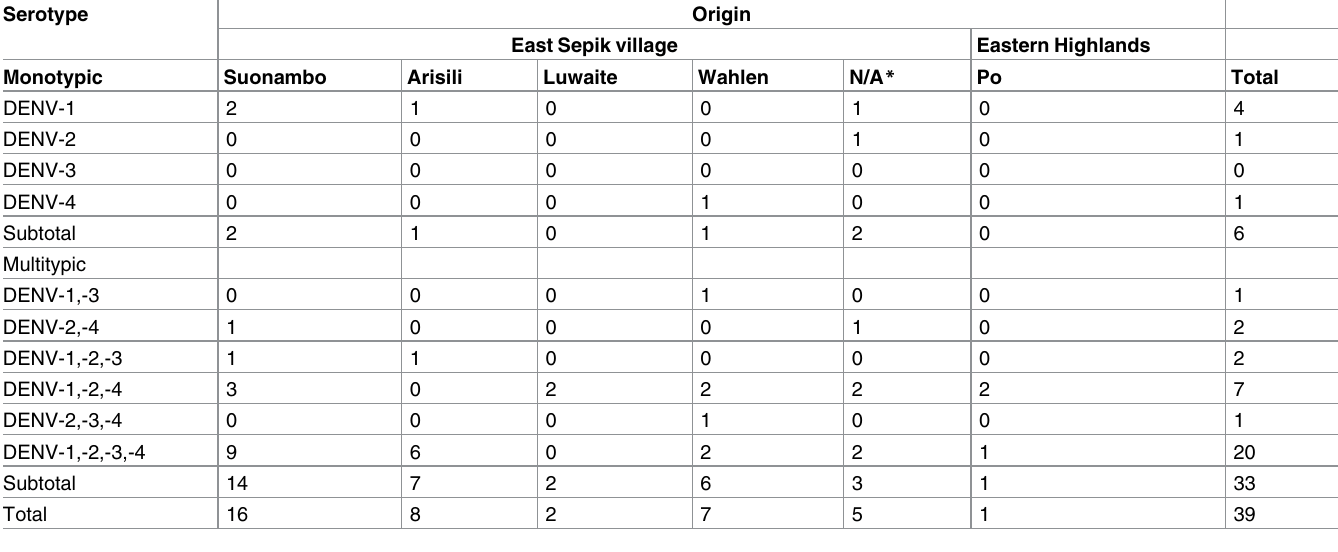
Table 3. Distribution of dengue seropositive samples,